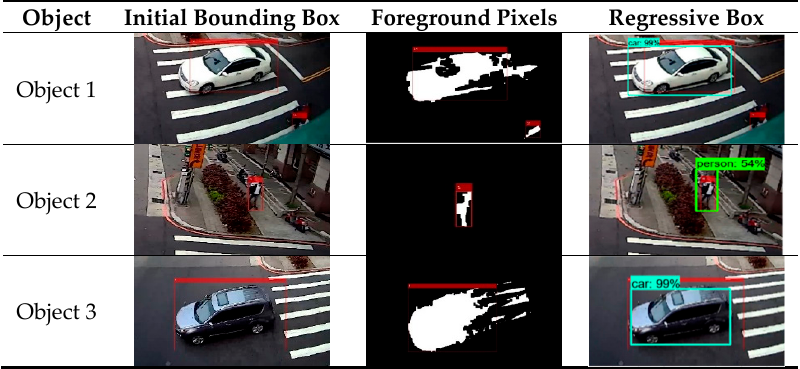
Figure 10. The motion segmentation and the recognition results.